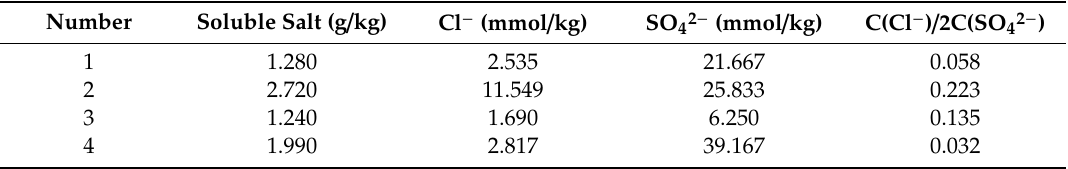
Table 2. The content of soluble salt, SO 42 − ion, and Cl − ion of cement-stabilized macadam base materials in filed.